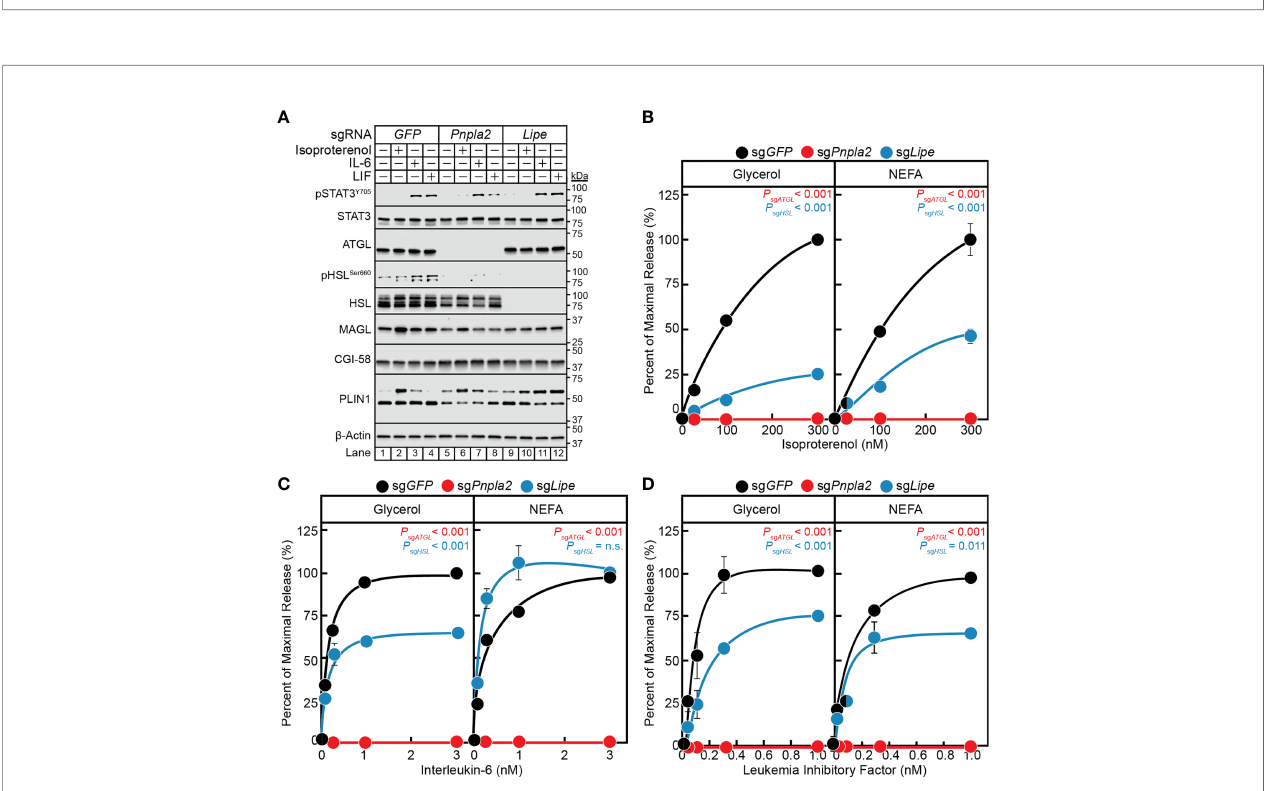
FIGURE 6 | The Role of ATGL and HSL in IL-6 and b -adrenergic Adipocyte Signaling and Lipolysis. (A – D) Pre-adipocytes in a 12-well format were infected with lentivirus containing Cas9 and sg GFP ( black ), sg Pnpla2 ( red ), or sg Lipe ( blue ) followed by differentiation as described in Methods . On day 8, differentiated adipocytes were treated in a fi nal volume of 1 ml of medium D with 3 µl DMSO and 3 µl PBS containing the indicated concentration of isoproterenol (A, B) , IL-6 (A, C) , or LIF (A, D) . After incubation for 24 hours, medium was collected and processed to measure concentrations of glycerol ( left panel ) or NEFA ( right panel ) and adipocytes were harvested and processed for immunoblot analysis (A) with the indicated antibodies as described in Methods . Glycerol levels are shown relative to the average 300 nM isoproterenol condition ( B , 578 µM), 3 nM IL-6 condition ( C , 140 µM), or 1 nM LIF condition ( D , 86 µM) of the sgGFP-treated adipocytes. NEFA levels are shown relative to the average 300 nM isoproterenol condition ( B , 123 µM), 3 nM IL-6 condition ( C , 57 µM), or 1 nM LIF condition ( D , 27 µM) of the sg GFP -treated adipocytes. Data is shown as mean ± SEM of three wells. P value calculated by using a two-way repeated measures ANOVA between sg GFP and the indicated sgRNA conditions. These results were con fi rmed in at least three independent experiments. Not signi fi cant (n.s.).